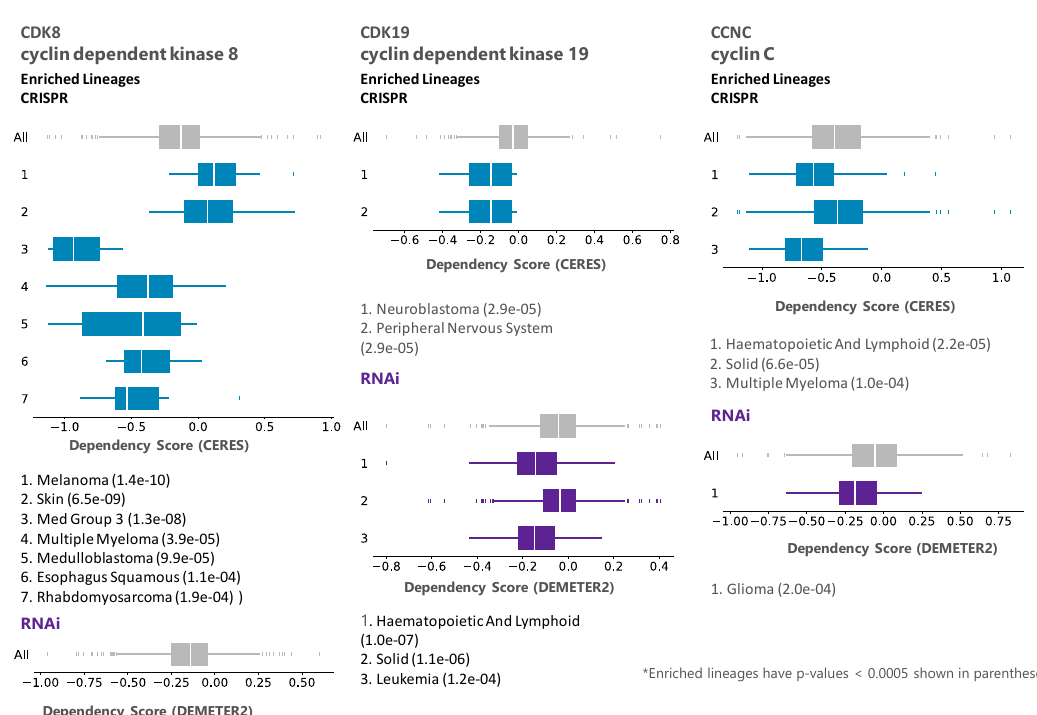
Figure 2. DepMap representation of lineage enrichment in the analysis of dependency of CRISPR and RNAi panels on CDK8, CDK19, and CCNC.